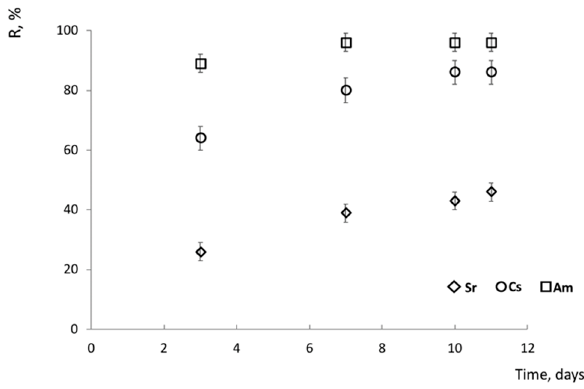
Figure 3. Kinetics of Cs, Sr and Am sorption on the discs of sample R-11.